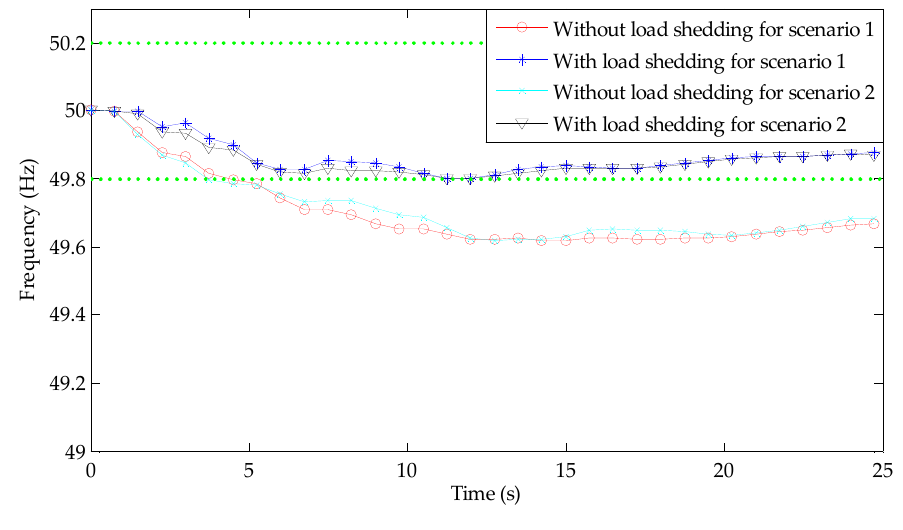
Figure 6. Frequency curves for Scenarios 1 and 2.